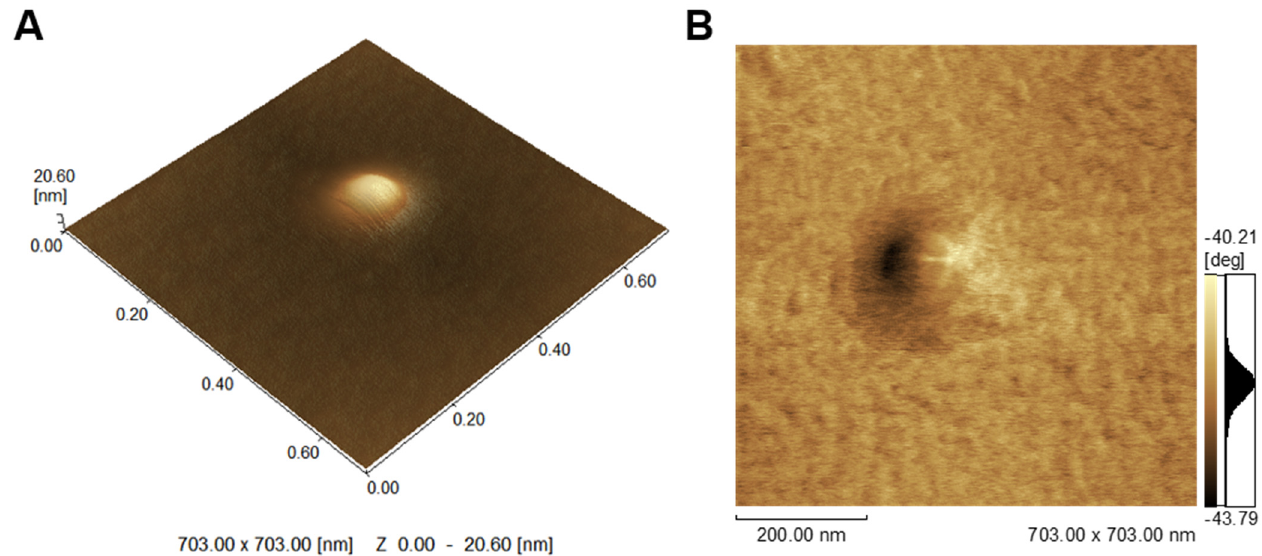
Figure 2. Tapping mode AFM images of isolated MV prepared in SCL buffer without phosphate and placed in fresh cleaved mica. ( A ) 3D topographic image showing the vesicle’s topology. ( B ) Phase image showing short range of phase shift in the vesicle’s topology, revealing a high protein complexity. Scanning was performed in air at 25 °C by using standard 4-sided pyramidal silicon probes with a resonance frequency ranging from 324 to 369 kHz (Nanosensors™, Switzerland). The scan rate was set at 0.2–0.3 Hz to prevent tip-induced vesicle deformations and/or damages. The vesicles sizes were determined by SPM Offline software, from Shimadzu. For each sample, N = 100 vesicles were analyzed.